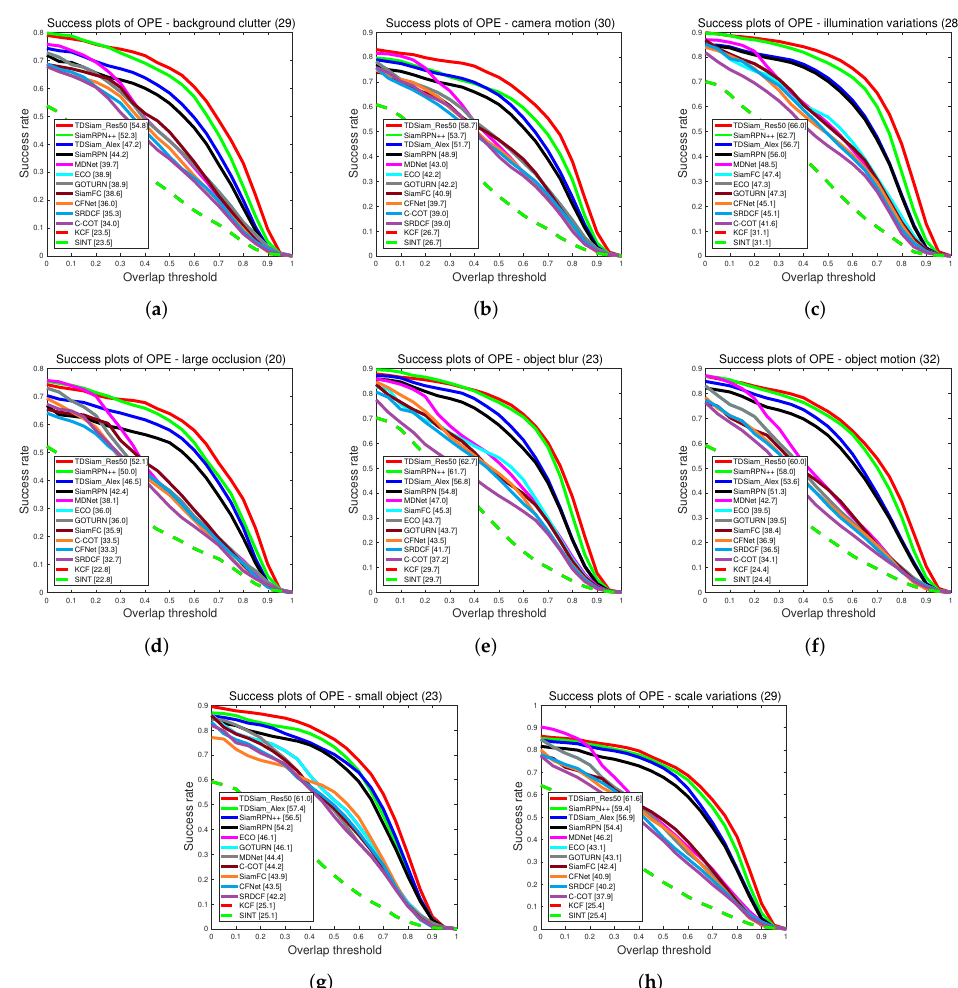
Figure 14. Success plots corresponding to some different scenarios. The UAVDT dataset was used for the evaluation. ( a ) Background Clutter; ( b ) Camera Motion; ( c ) Illumination Variations; ( d ) Large Occlusion; ( e ) Object Blur; ( f ) Object Motion; ( g ) Small Object; ( h ) Scale